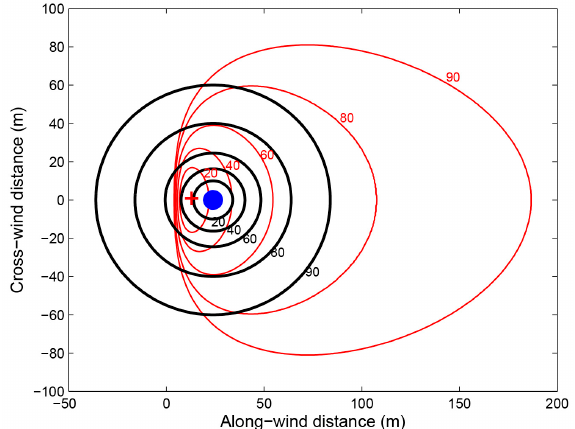
Figure 4. Cumulative footprint contours of the flux (red lines) and hemispherical spectral observations made at nadir (black circles) at the Xiao Tangshan EC site for a height above the target surface of 20 m. The blue circular area represents the total surface source area of the conical spectral observations (FOV of 25°). The center of this circle is the location of the EC tower. The cross marks the location of the flux footprint peak.